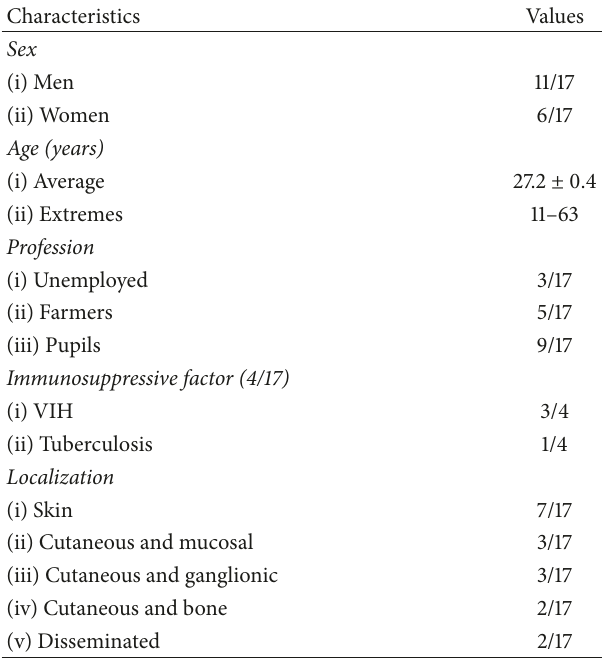
Table 1: Epidemiological characteristics of patients.